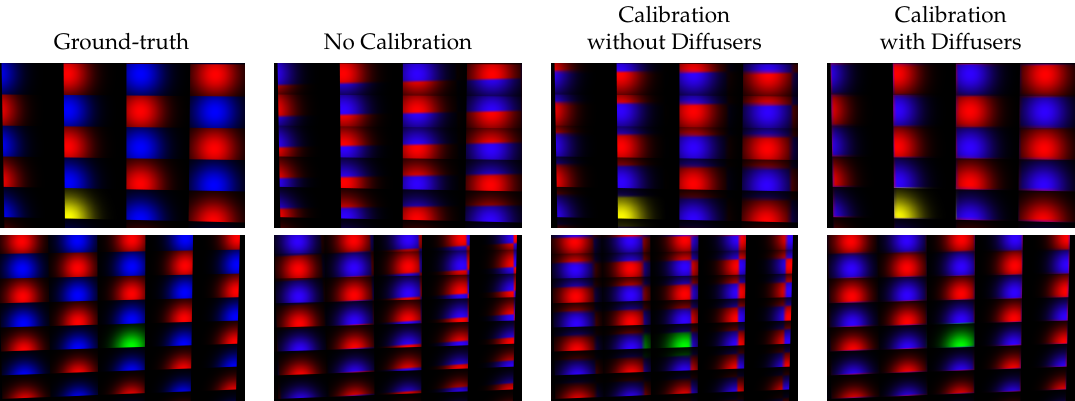
Figure 5. Close-ups of a simulated DDHOE while projecting the test pattern. The first column represents the ground-truth. The second column represents the case in which no calibration is applied. The third column represents the calibration method which does not use the diffuse markers. The last column is the result of the proposed calibration which does utilize the diffuse corners. The yellow and green cells indicate that the identification of the micromirrors is correct in both calibration methods. The results from the proposed approach match well with the